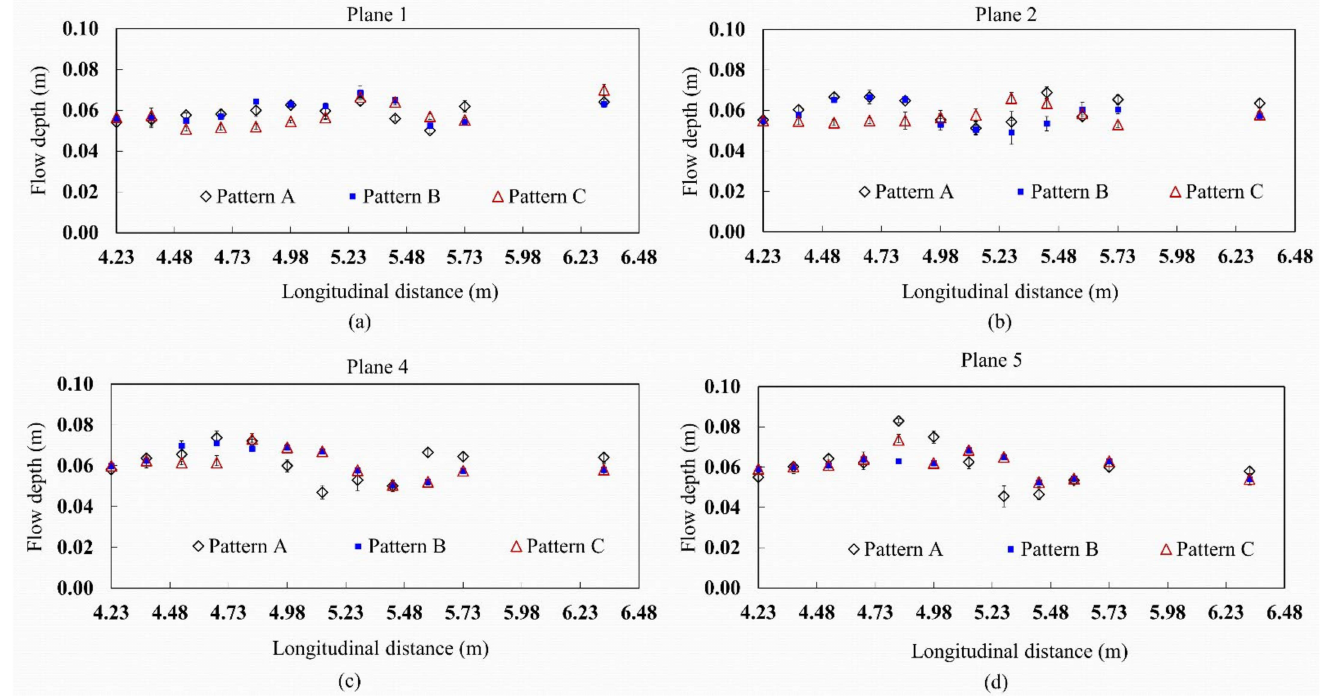
Figure 4. Observed water surface profiles for pattern A, B, and C when Q = 0.110 m 3 /s: ( a ) plane 1; ( b ) plane 2; ( c ) plane 4; and ( d ) plane 5. The uncertainty associated with the water level measurements is shown as error